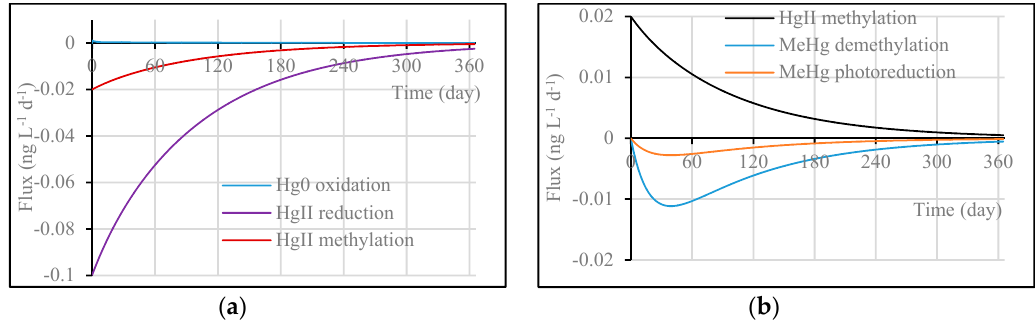
Figure 8. W2 computed ( a ) HgII and ( b ) MeHg concentrations and internal fluxes in the water column.